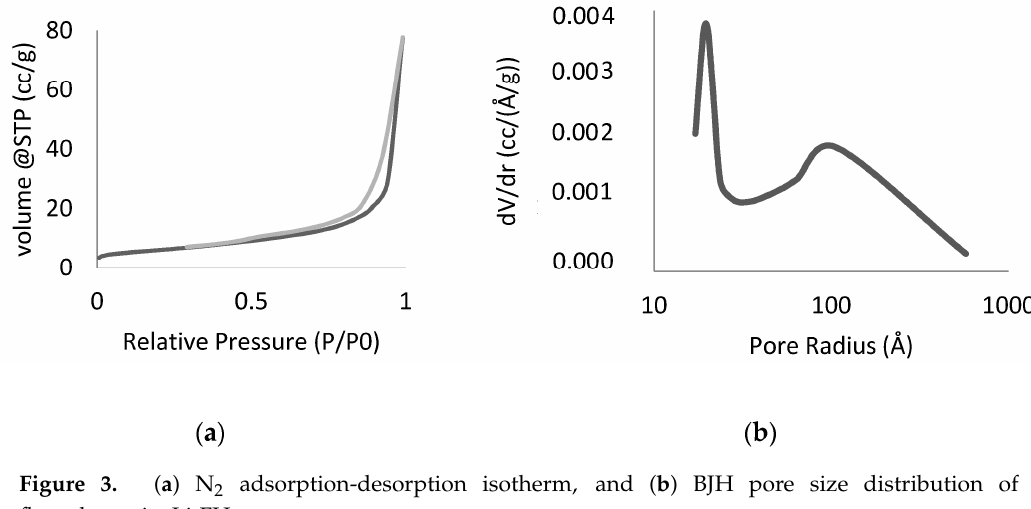
Figure 3. ( a ) N 2 adsorption-desorption isotherm, and ( b ) BJH pore size distribution of fluorohectorite Li-FH.